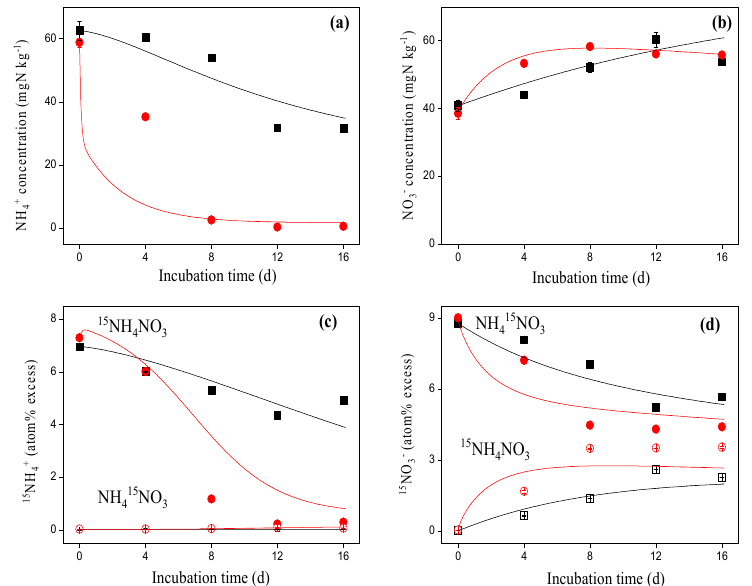
Figure 2. Measured (points) and modeled (lines) concentrations ( a , b ) and 15 N enrichment of NH 4+ and NO 3 − ( c , d ) in the Brachiaria (squares) and Eremochloa soil (circles) treated with either 15 NH 4 NO 3 or NH 4 15 NO 3 . Vertical bars denote the standard deviation of the mean ( n = 3).